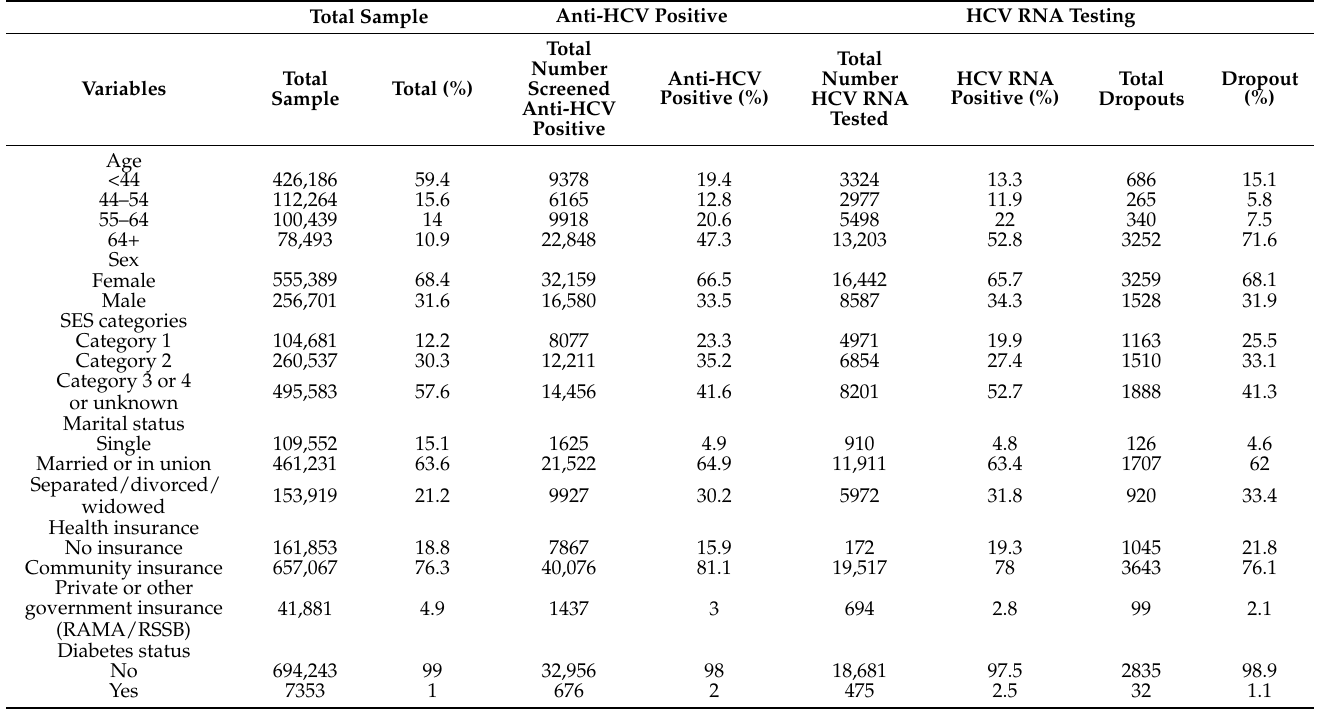
Table 2. Characteristics of patients screened and treated during the mass screening campaign for hepatitis C virus in Rwanda